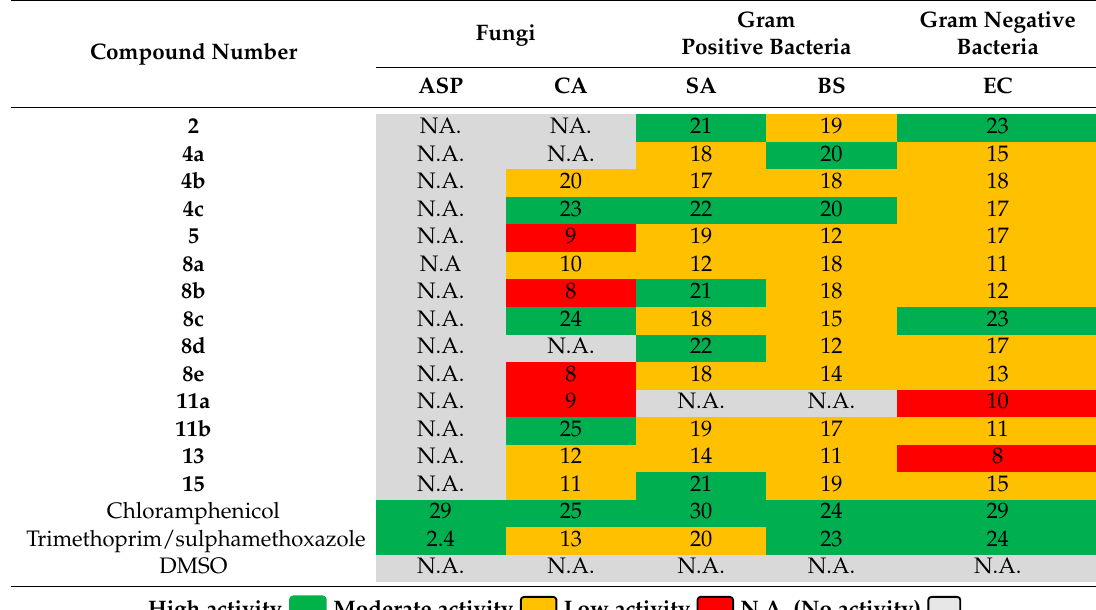
Table 2. Antimicrobial activity of compounds 2 , 4a – c , 5 , 8a – e , 11a,b , 13 , and 15 compared to reference drug. Compound Number